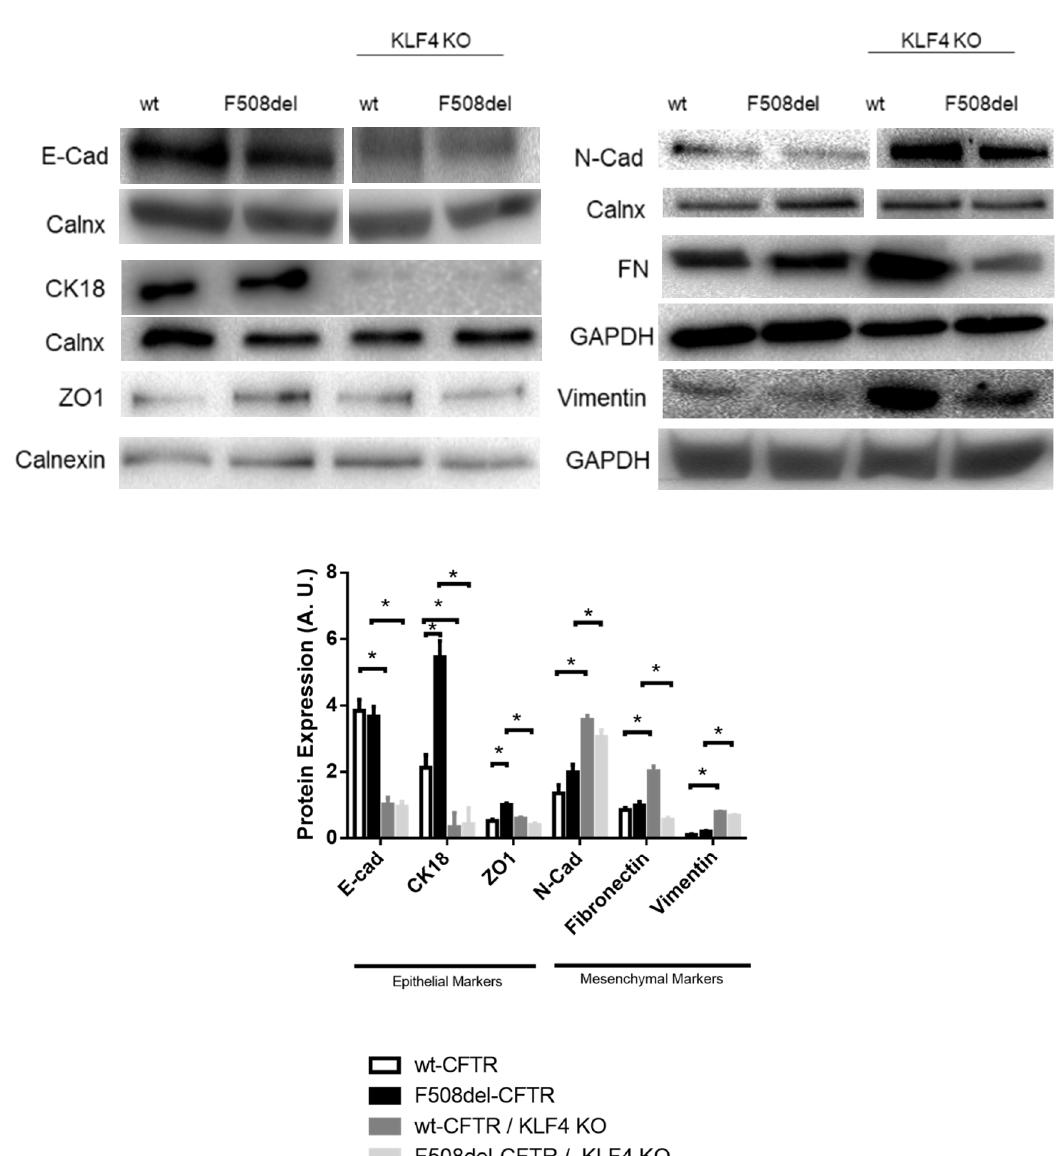
Figure 4. Impact of KLF4 KO on differentiation markers. Protein levels on wt- and F508del-CFTR CFBE and their respective KLF4 KO counterparts. Representative WB of E-Cad, N-Cad, CK18, ZO-1, fibronectin (FN), and vimentin. Calnexin, GAPDH, and vinculin were used as loading control. Data are normalized to loading control and showed as arbitrary units (A.U.; n = 3, unpaired t -test, * is p < 0.05). KLF4 KO showed no marked impact on the levels of other di ff erentiation markers, such as Cx31, Occludin, and CK5, as well as other TFs such as SNAIL + SLUG (Figure S3). Recently, immortalized human airway basal cells that retain multipotent di ff erentiation capacity over long-term culture were developed (basal cell immortalized nonsmoking 1.1—BCi NS1.1). These cell lines display a tremendous potential for studying the processes underlying epithelial di ff erentiation in the airways [42]. Having access to these cells, we decided to ascertain the expression of KLFs during BCi di ff